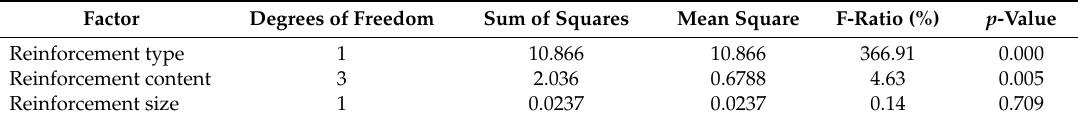
Table 4. One-way ANOVA of shrinkage in the transverse direction.